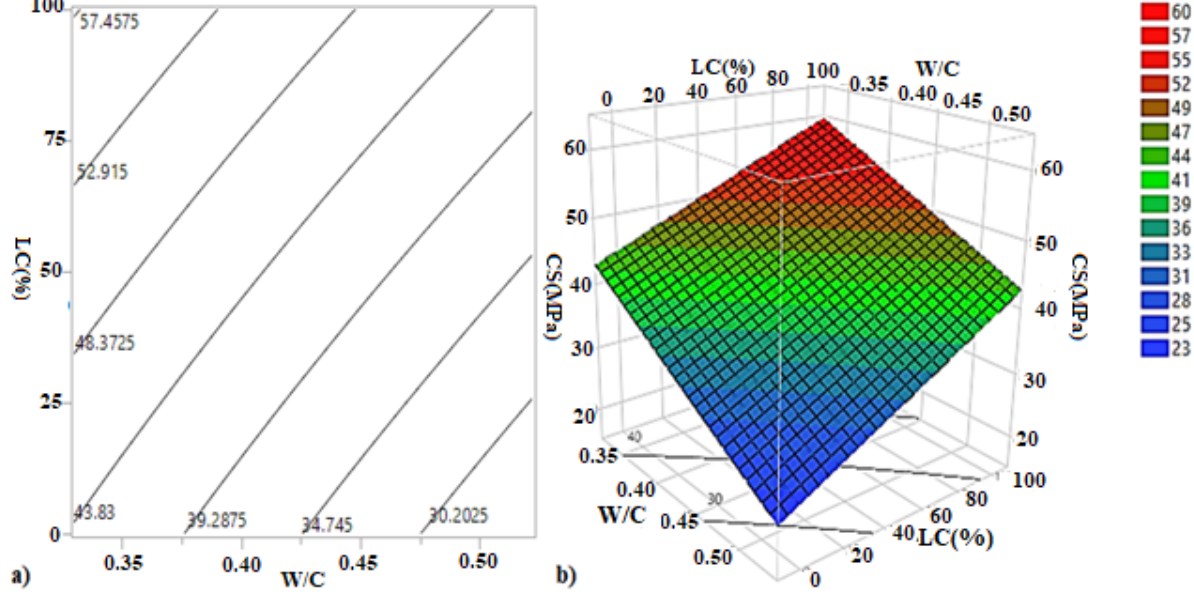
Figure 10. ( a ) Iso-response curves and ( b ) response surfaces of compressive strength of the longitudinal confinement.